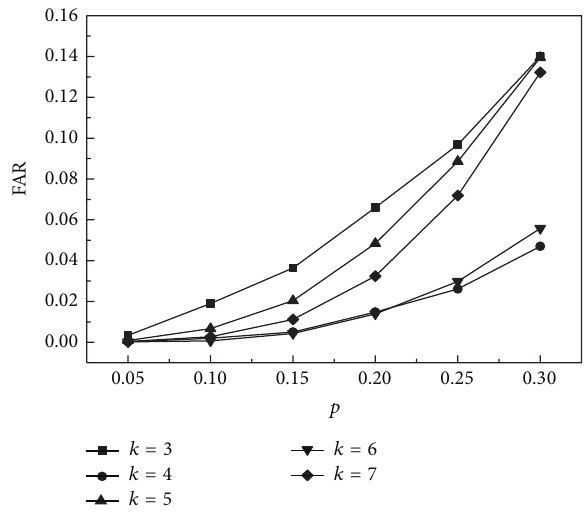
Figure 7: FAR’s relationship with 𝑝